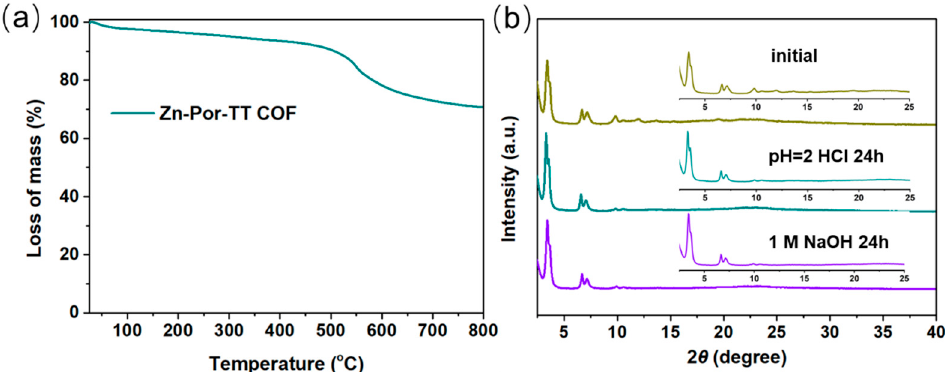
Figure 5. ( a ) TGA profile of Zn-Por-TT COF in N 2 ; ( b ) PXRD patterns of Zn-Por-TT COFs before (dark yellow) and after treatments in the solution of HCl (pH = 2, cyan) and NaOH (1 M, violet).